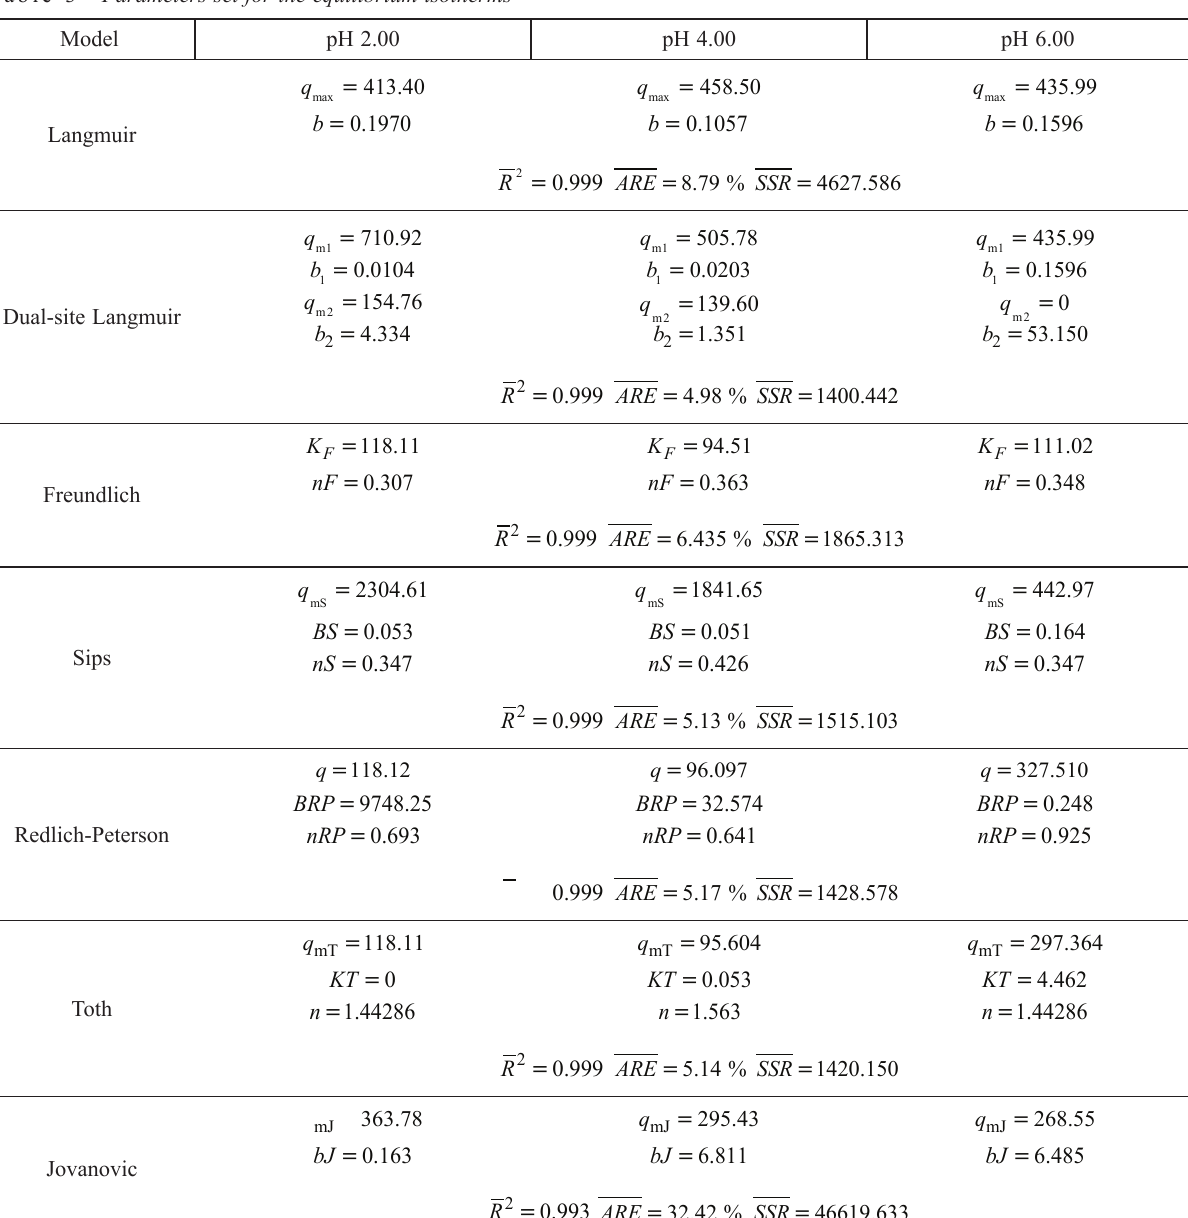
Table 3 – Parameters set for the equilibrium isotherms